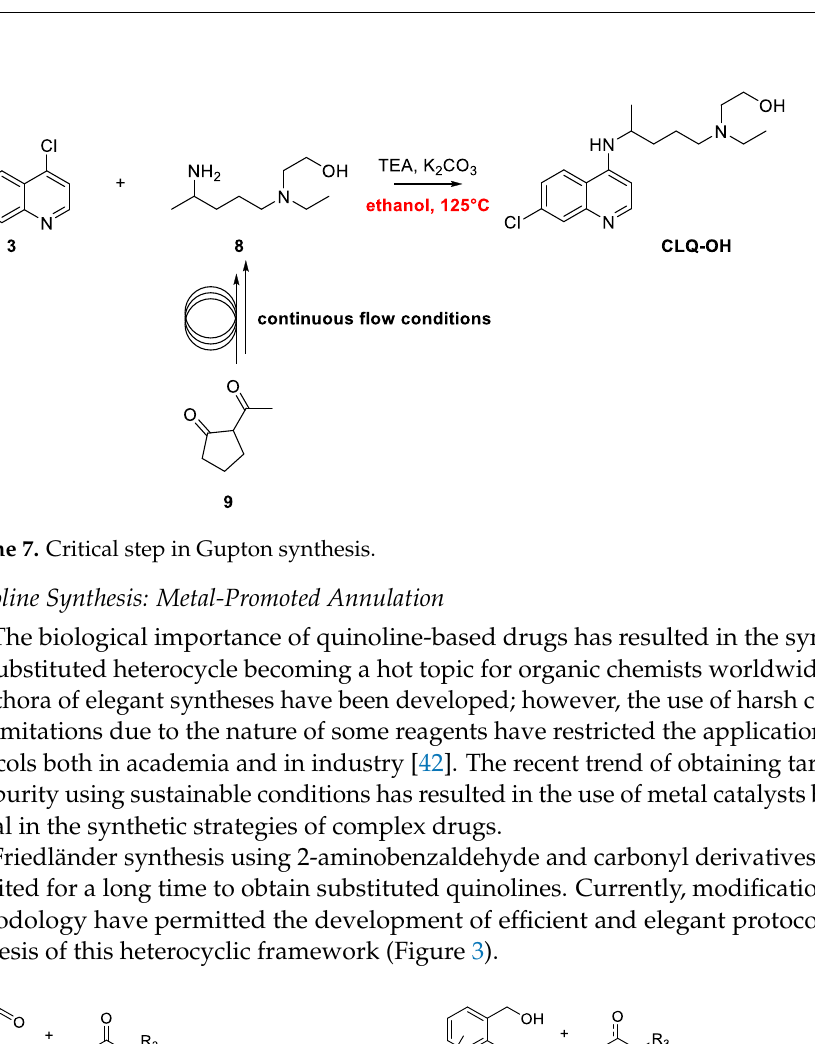
Figure 3. Friedländer classical condensation ( A ) and metal-catalyzed Friedländer condensation ( B ).